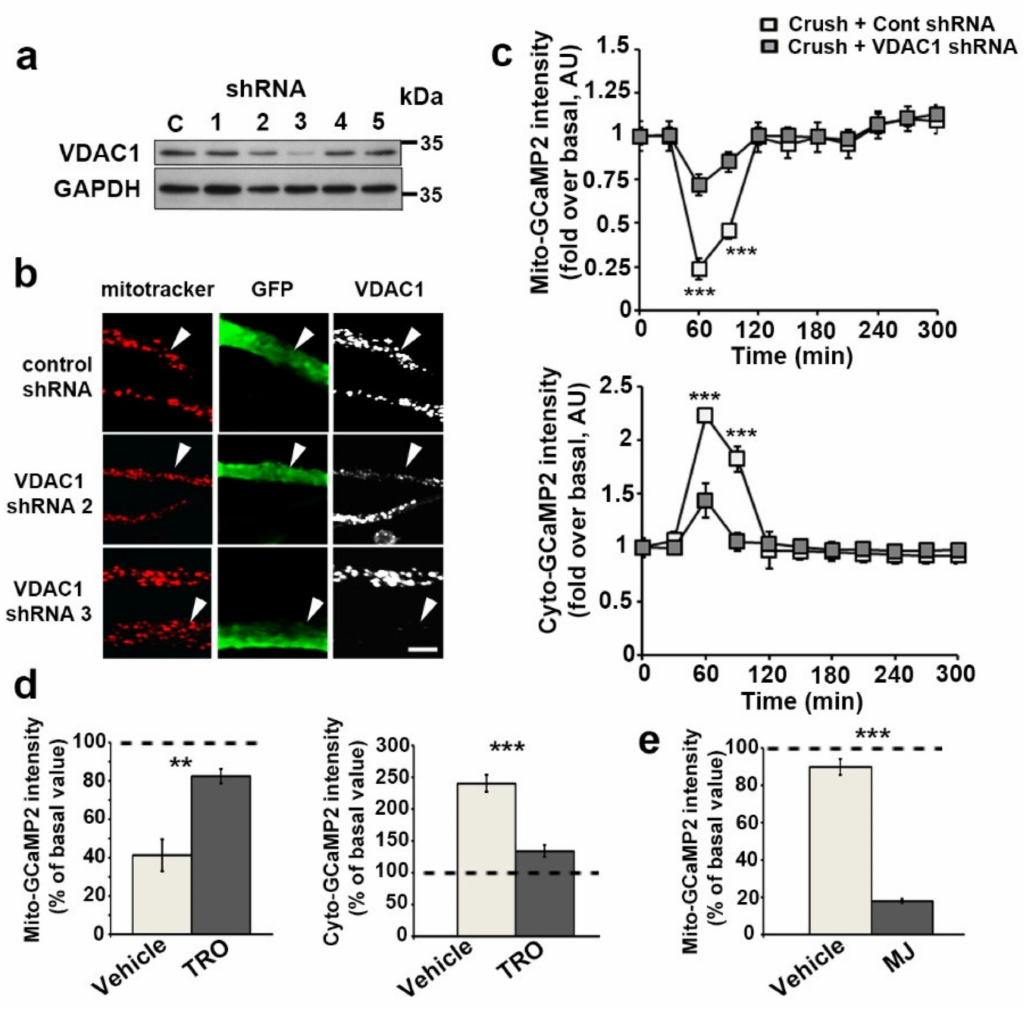
Figure 4. VDAC1 mediates mitochondrial calcium release during SC demyelination. ( a ) MSC80 SC were transfected with plasmids expressing puromycin and a control shRNA with no mammalian target (C) or 5 shRNAs (1–5) specifically targeting mouse VDAC1 under a U6 promoter. After a selection with puromycin, cells were lysed and their VDAC protein expressions were analyzed by WB. GAPDH is used as loading control. ( b ) AAV virus expressing VDAC1 shRNAs 2 or 3 in addition to GFP were injected in the sciatic nerve of mice. Three weeks later animals were sacrificed and the expression of VDAC in infected SC was analyzed by immunostaining on teased fibers. Infected cells expressing control shRNA and GFP (green, arrowheads) show mitochondria (mitotracker, red) harboring VDAC (white) while cells expressing VDAC1 shRNAs show reduced expression of VDAC. Scale bar = 5 µ m. Same magnification for all pictures. ( c ) AAV virus expressing VDAC1 shRNAs 2 or 3 in addition to mito- or cyto-GCaMP2o was injected in the sciatic nerve of mice. The average fluorescence intensity of the mito-GCaMP2 (upper panel) and cyto-GCaMP2 (lower panel) probes was measured for more than 100 mitochondria at the successive indicated time points in non-crushed (No Crush, n = 3 mice) and crushed nerves (Crush, n = 4–5 mice). The probe fluorescence intensity is normalized over the basal condition before crush. Error bars indicate SEM. Statistical tests are two-way ANOVA Sidak post hoc test comparing crushed with control shRNA to crushed with VDAC1 shRNAs conditions. All mice were 8 to 11 weeks old. ( d ) Sciatic nerves transduced with viruses expressing mito-GCaMP2 (left panel, n = 3 mice and >100 mitochondria for both TRO and vehicle) or cyto-GCaMP2 (right panel, n = 3 and > 100 mitochondria mice for both TRO and vehicle) were injected with 2 µ L of 20 µ M TRO19622 (TRO) solution or vehicle 30 min before nerve injury and then live imaging. Probes’ fluorescence intensities were measured before injury and then 60 min